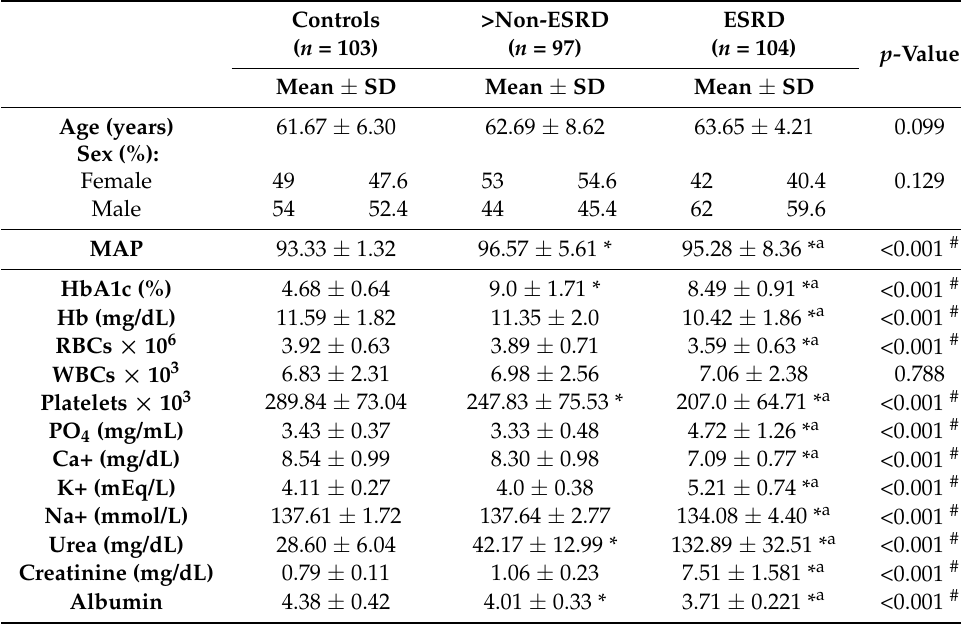
Table 2. Demographic and laboratory data of the studied groups.